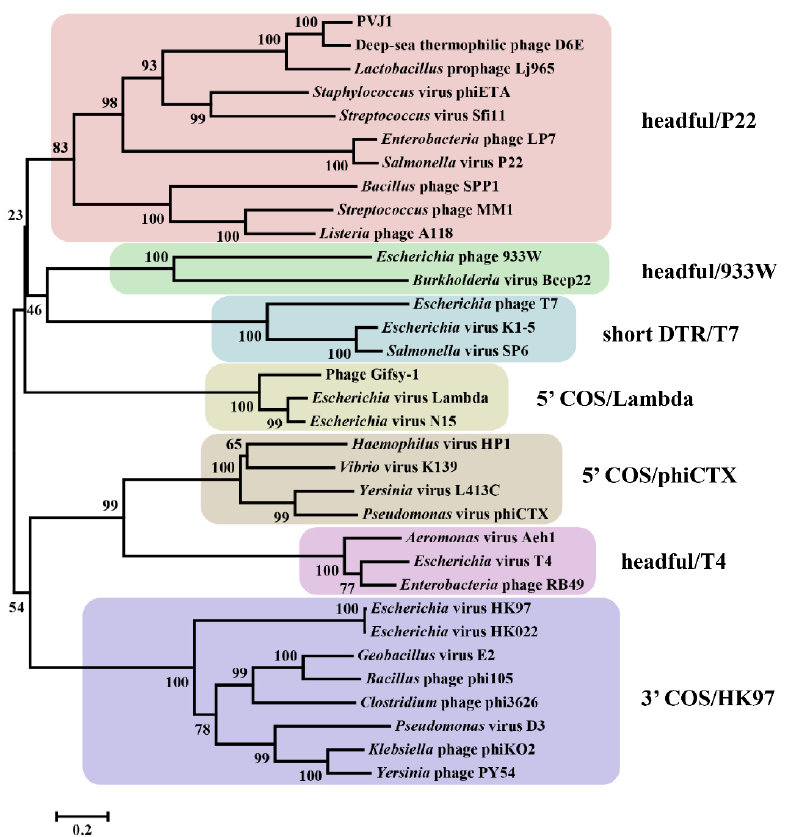
Figure 6. Phylogenetic analysis of the large terminase subunits of PVJ1 and selected phages. The phylogenetic tree was constructed by using the neighbor-joining method. Bootstrap analysis was performed with 1000 repetitions.